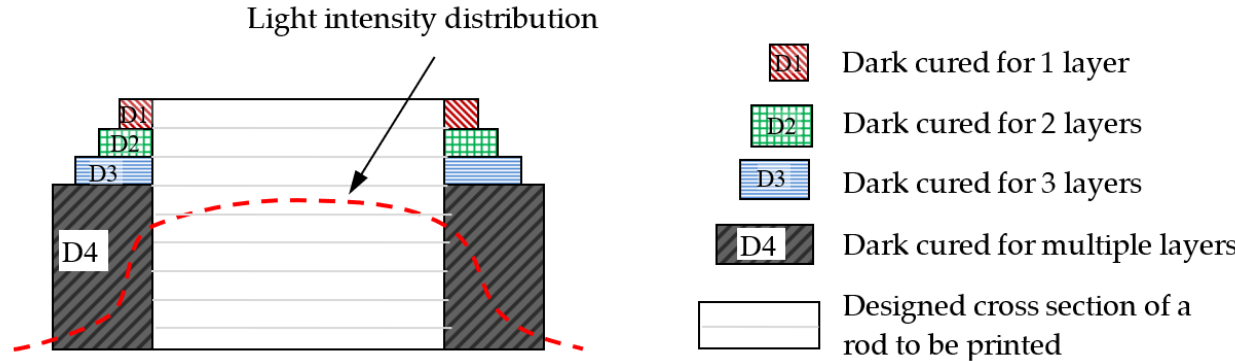
Figure 4. Schematic illustration on the effect of dark curing on the printed dimension of a square section.